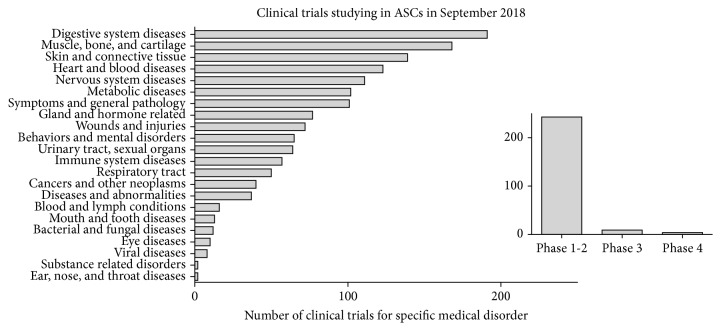
A total number of 282 clinical trials using ASC were ongoing on the 11th of September 2018, based on http://www.clinicaltrials.gov. Clinical studies were categorized based on the disease or target tissue of the treatment. Only 13 out of 282 trials had progressed into phase III or IV. A commercial sponsor was involved in 116 trials.